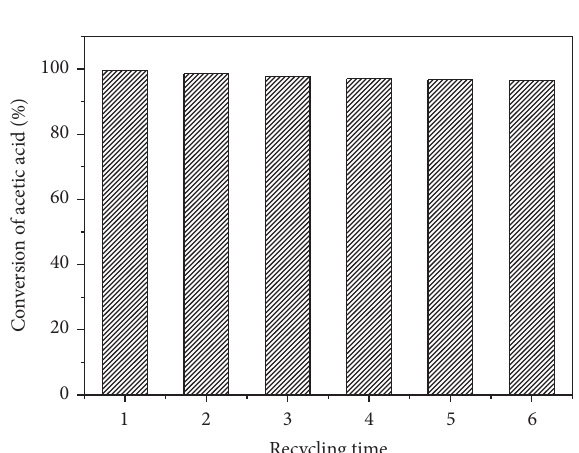
Figure 5: Recycling of [ PVPP-BS ] HSO 4 in the synthesis of n-butyl